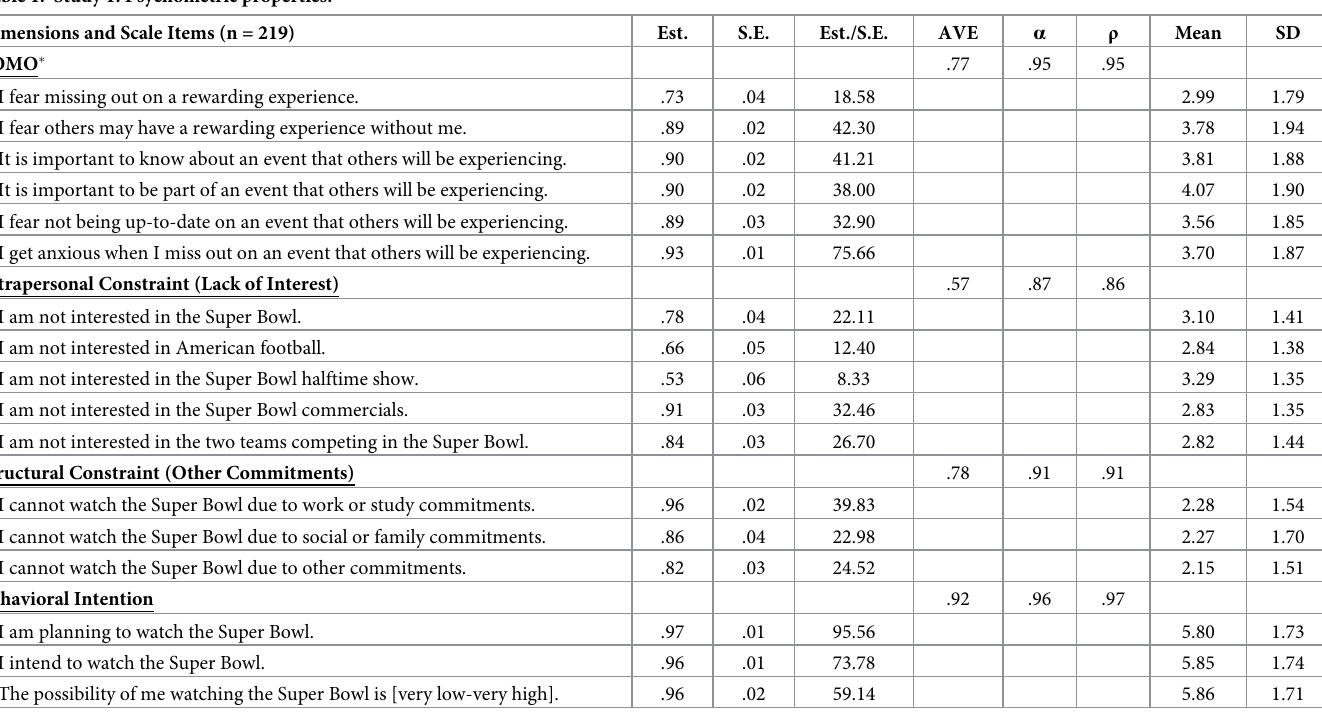
Table 1. Study 1: Psychometric